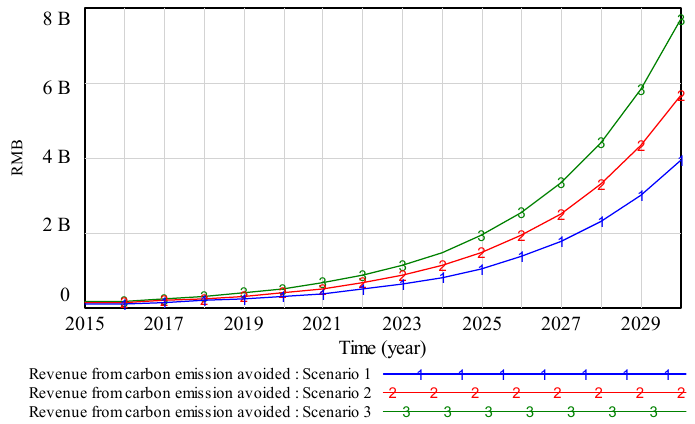
Figure 4. The revenue from avoided carbon emissions.